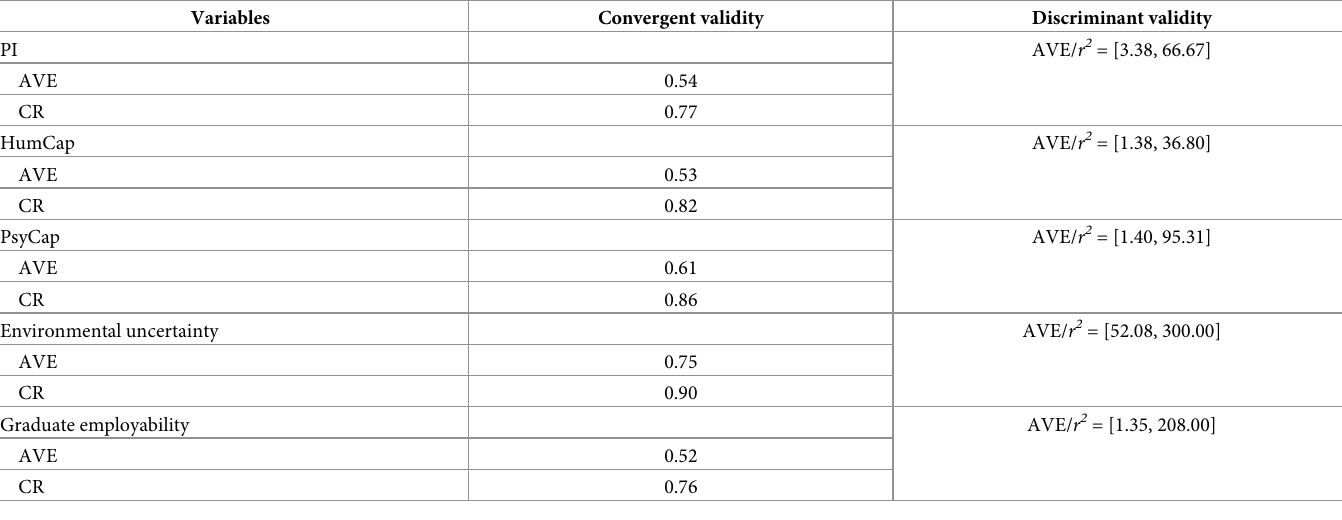
Table 2. Tests for convergent and discriminant validity.